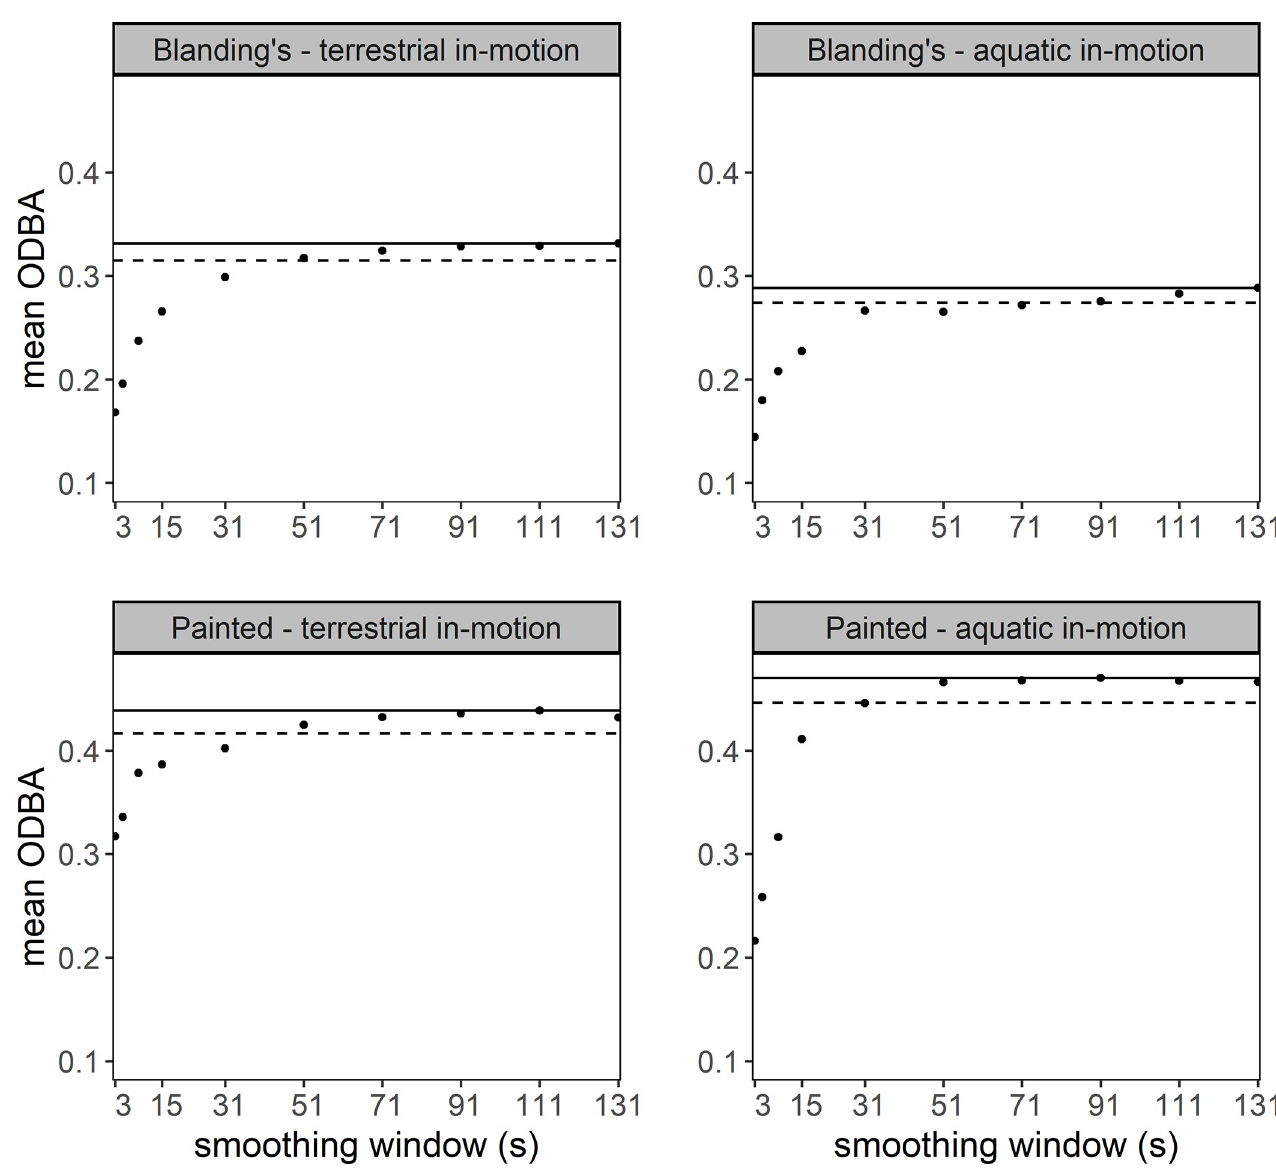
Fig 2. Mean overall dynamic body acceleration (ODBA) as a function of the duration of the smoothing window for Blanding’s and Painted turtle terrestrial and aquatic motion, using accelerometer data sampled at 1 Hz. Maximum ODBA value (solid line) and 95% of the maximum ODBA value (dashed) are